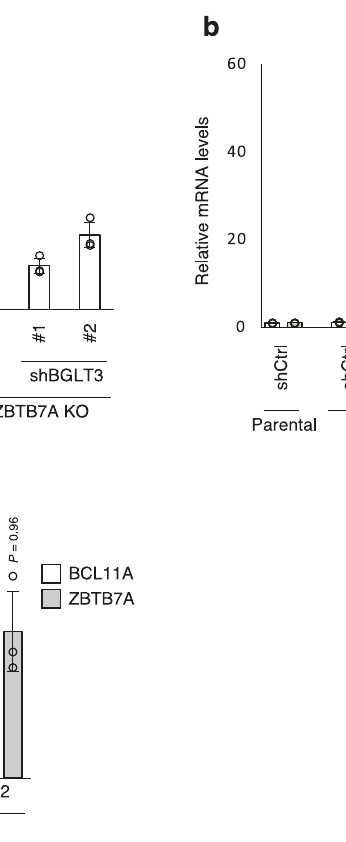
independent experiments. c Relative expression of BCL11A and ZBTB7A in BGLT3- overexpressing HUDEP-2 cells. Data are mean±SD from three independent experiments. P -value was calculated by the one-way ANOVA with Tukey ’ s post hoc